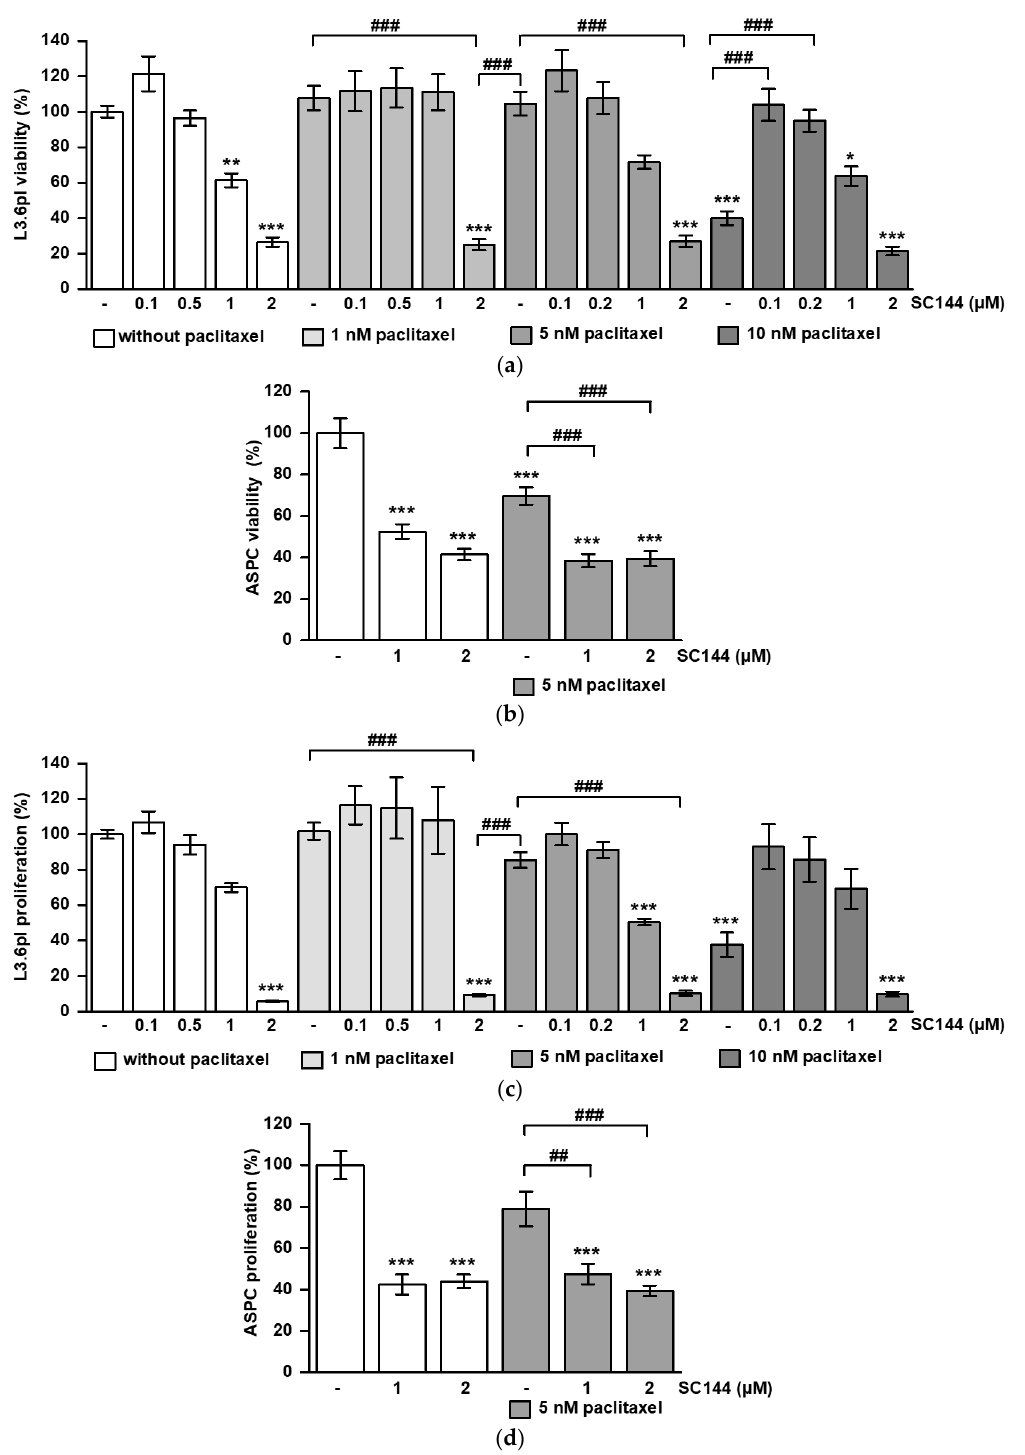
Figure 2. Effects of SC144 and paclitaxel on cell viability and proliferation. L3.6pl and ASPC cells were treated with different concentrations of SC144 and paclitaxel alone or in combination. The graphs show the results obtained from MTT and BrdU assays on ( a ) cell viability in L3.6pl, ( b ) cell viability in ASPC, ( c ) proliferation in L3.6pl, and ( d ) proliferation in ASPC. The data are given as mean values ± SEM from at least two independent experiments; the mean control value was set to 100%. * p < 0.05, ** p < 0.01 and *** p < 0.001 versus control; ## p < 0.01 and ### p < 0.001 versus